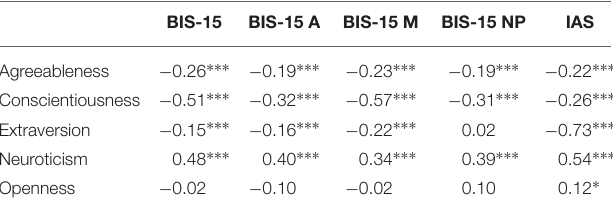
TABLE 5 | Correlations between impulsivity (BIS-15), social anxiety (IAS) and the big five of